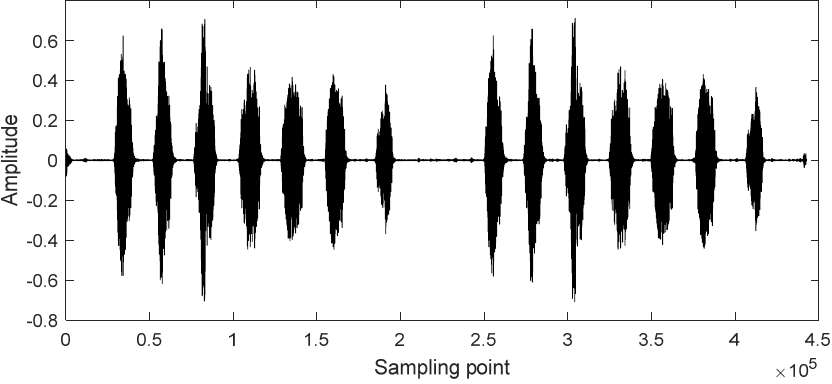
Figure 4. Signal of clean bird vocalization.